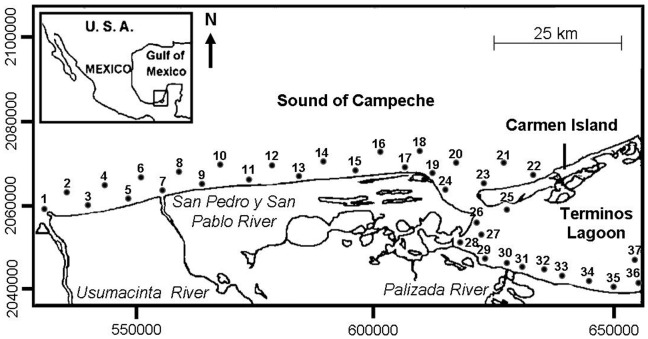
Location of the study area and of the 37 sampled stations (UTM coordinates).